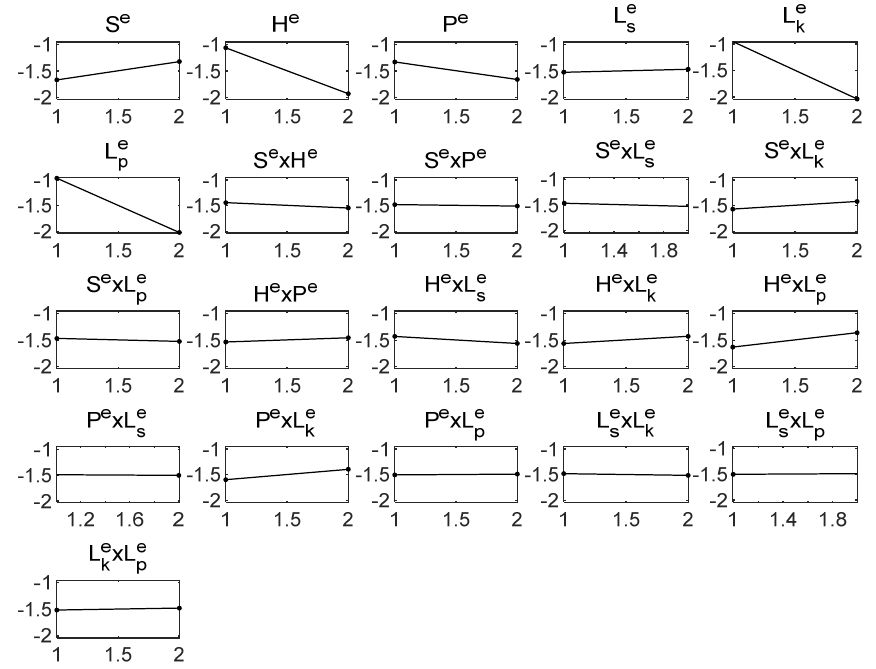
Figure 10. Insertion loss | S 21 | trend chart of flexible interconnection considering interaction effect. Table 7. Electromechanical coupling parameter identification of flexible interconnection. Strong Coupling Weak Coupling Uncoupling